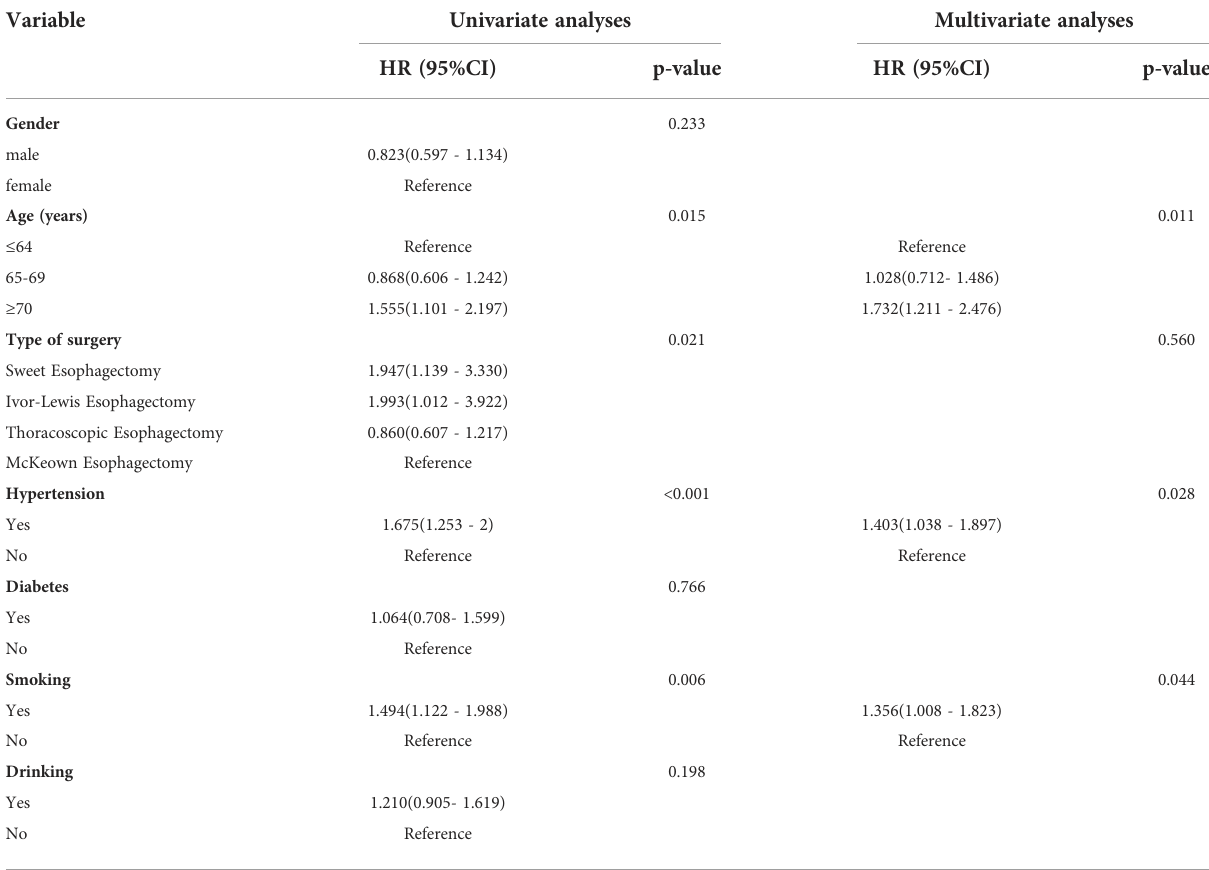
TABLE 2 Risk factor analysis of patients with EC in the training set.